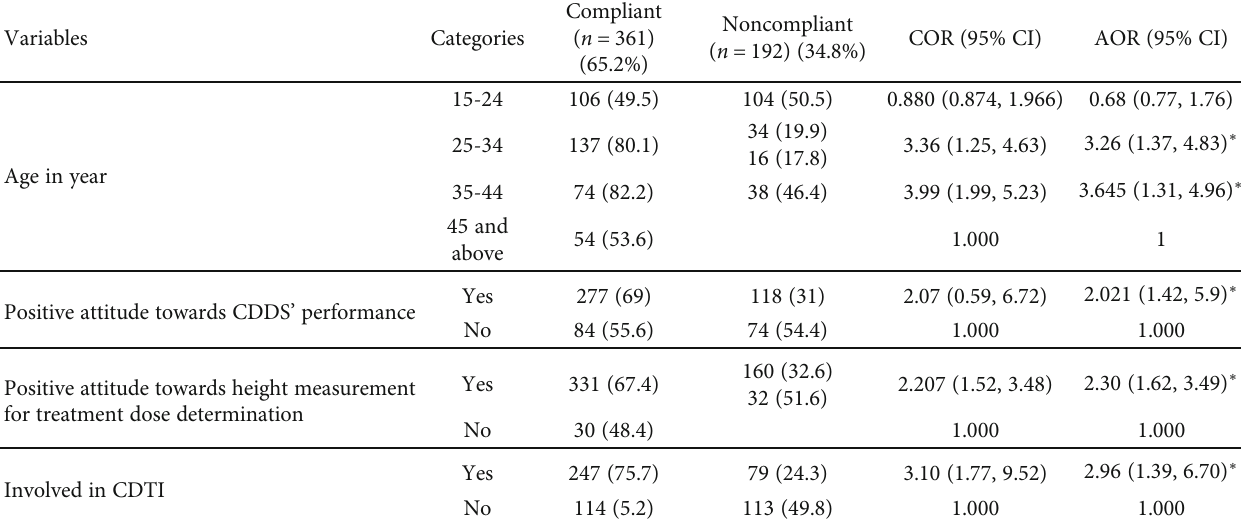
Table 5: Independent predictors of compliance to ivermectin treatment in the Semen Bench District, Bench Maji Zone, Southwest Ethiopia, June 2018 ð n = 553 Þ